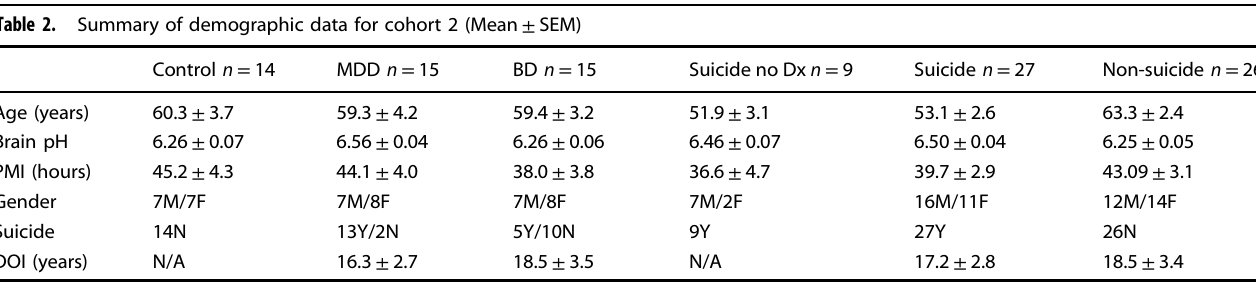
Table 2. Summary of demographic data for cohort 2 (Mean ± SEM)